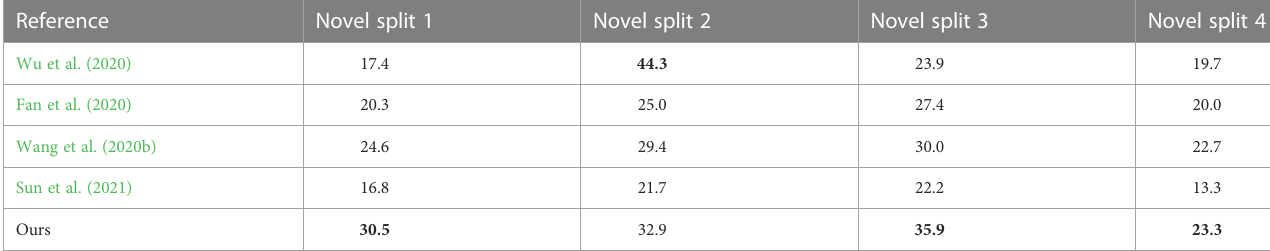
TABLE 3 FSIP52 novel classes ’ AP50 in 13-way 10-shot